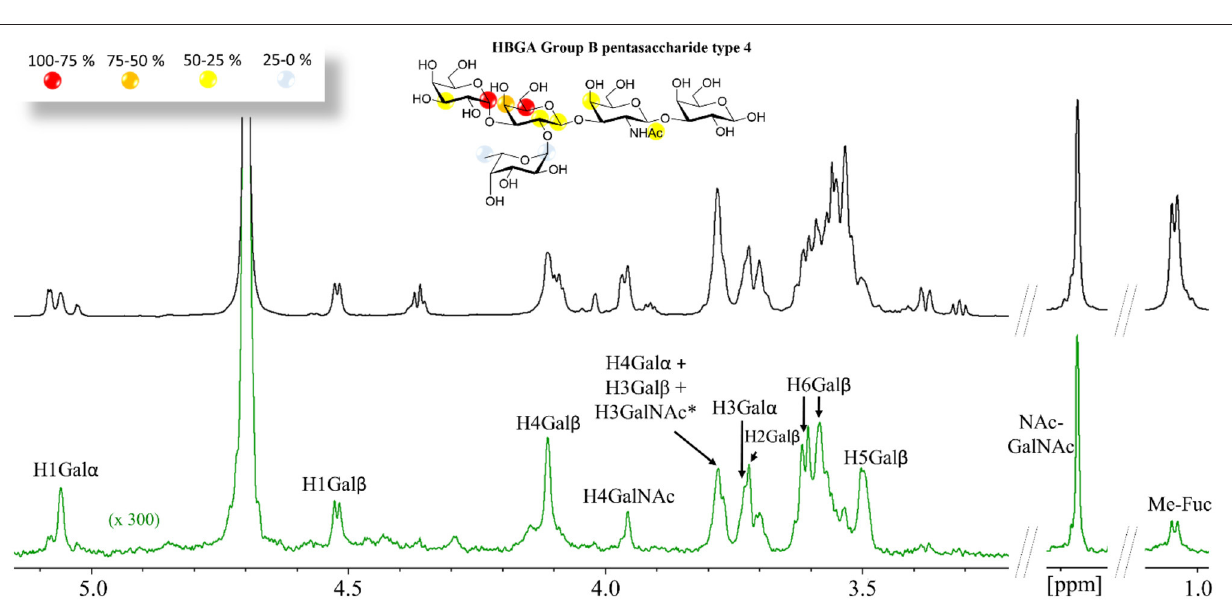
FIGURE 2 | 1 H STD NMR experiment for the complex formed by the B type-4 pentasaccharide and Gal-4N (50:1 molar ratio). Top : the reference spectrum (black, off-resonance). Bottom : the STD NMR spectrum (green, on-resonance at the aromatic region). The 1 H-NMR signals showing STD effect are annotated. The epitope mapping (relative STD) is shown in the ligand structure. *overlapping proton